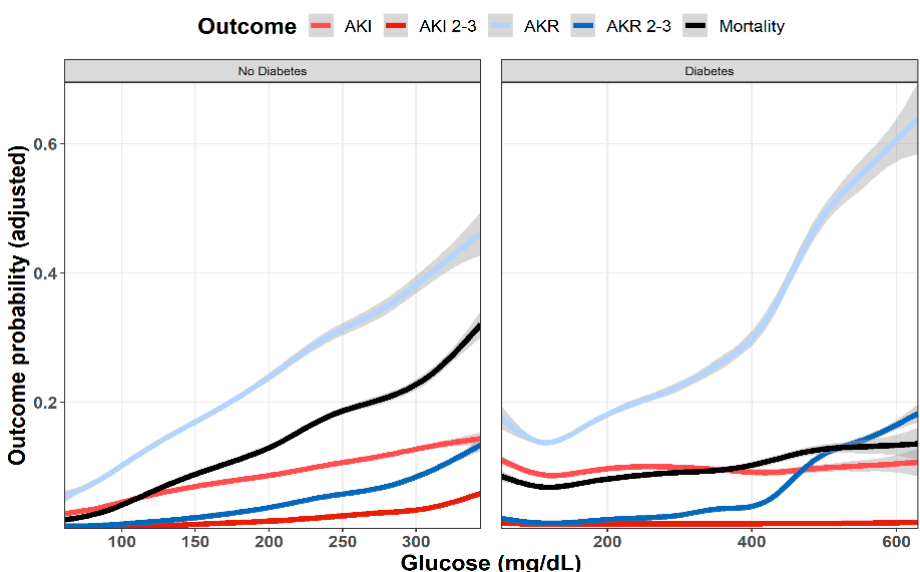
Figure 1. Predicted probability of various outcomes (AKI, AKI stages 2–3, AKR, AKR stages 2–3, dialysis and mortality at 30 days) as a function of baseline glucose levels. Lowest and highest 0.5% percentile of patients by glucose levels were excluded. Data were plotted using cubic splines.